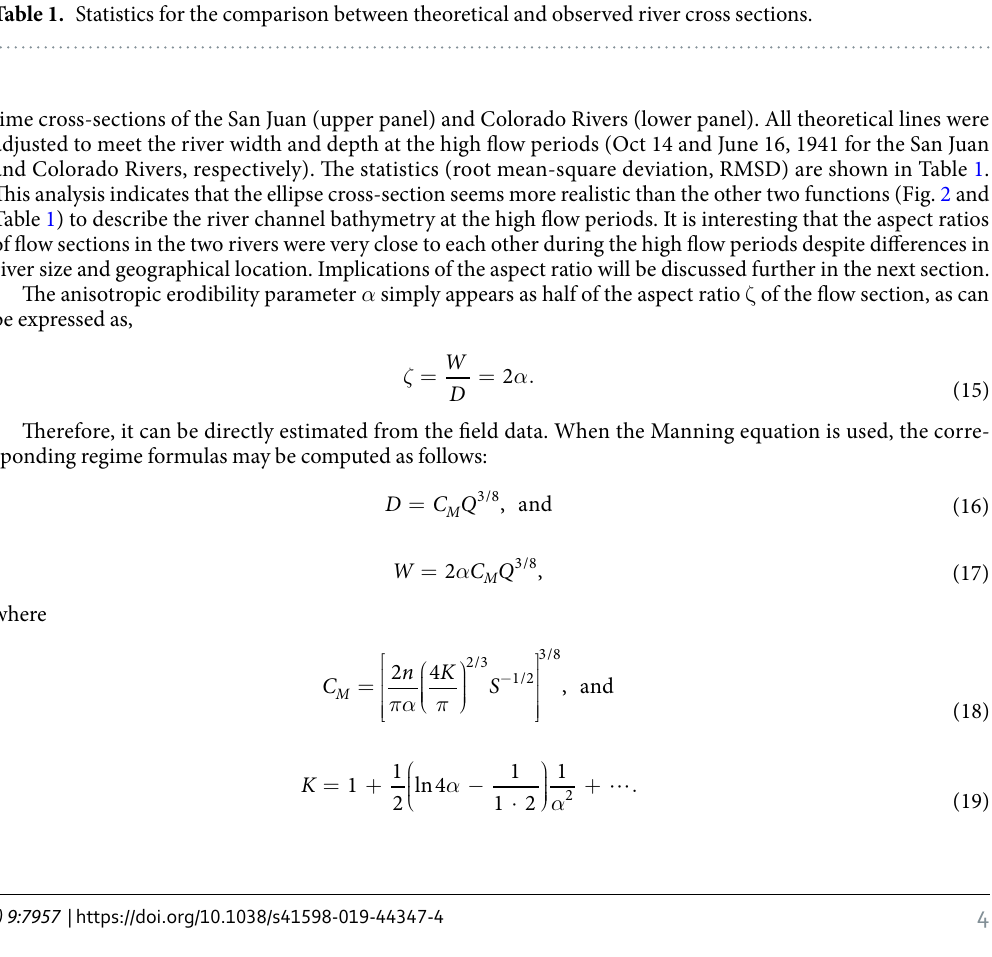
Root-mean-square deviation (RMSD) (m) Aspect Date ratio, ζ Ellipse Catenary Cosine N San Juan R. Colorado R. Table 1. Statistics for the comparison between theoretical and observed river cross